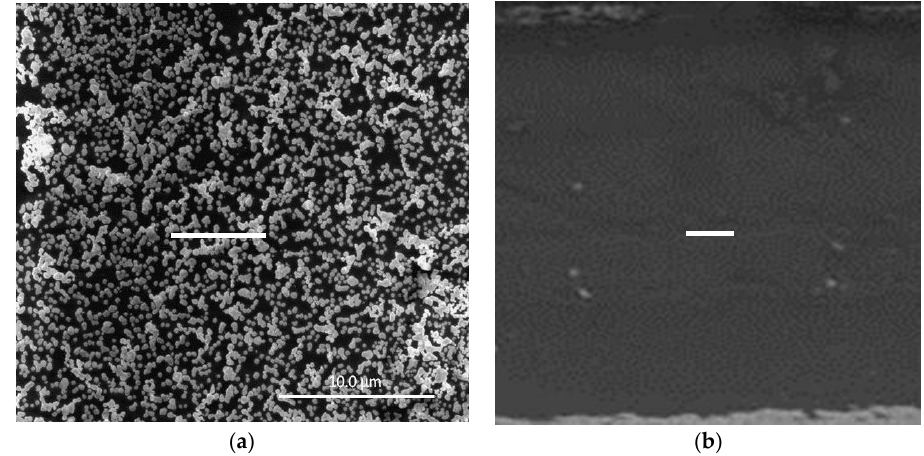
Figure 1. SEM images showing ( a ) surface-confined gold nanoparticle (AuNP) clusters at maximum Au(III) loading and ( b ) the cross-section of a polymer inclusion membrane (PIM) coated with AuNPs under the same conditions which is virtually free of AuNPs. The white bars are equal to 10 μm.